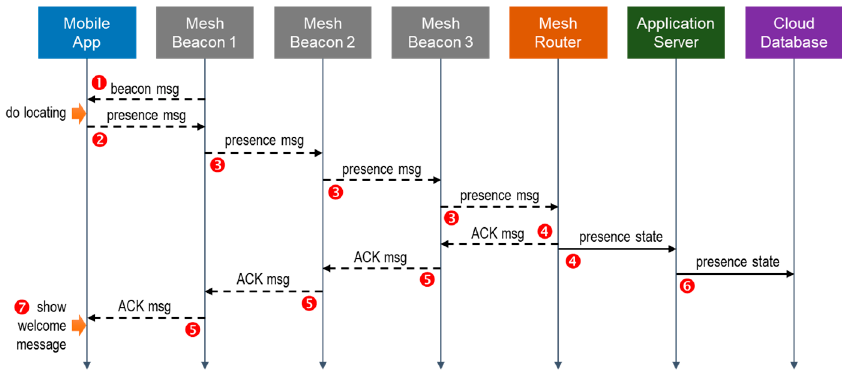
Figure 2. An example of the flow of operations.